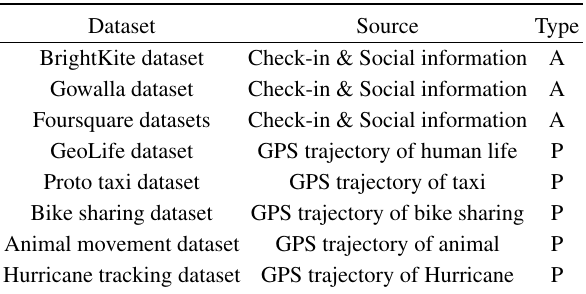
Table 5 Summary of trajectory